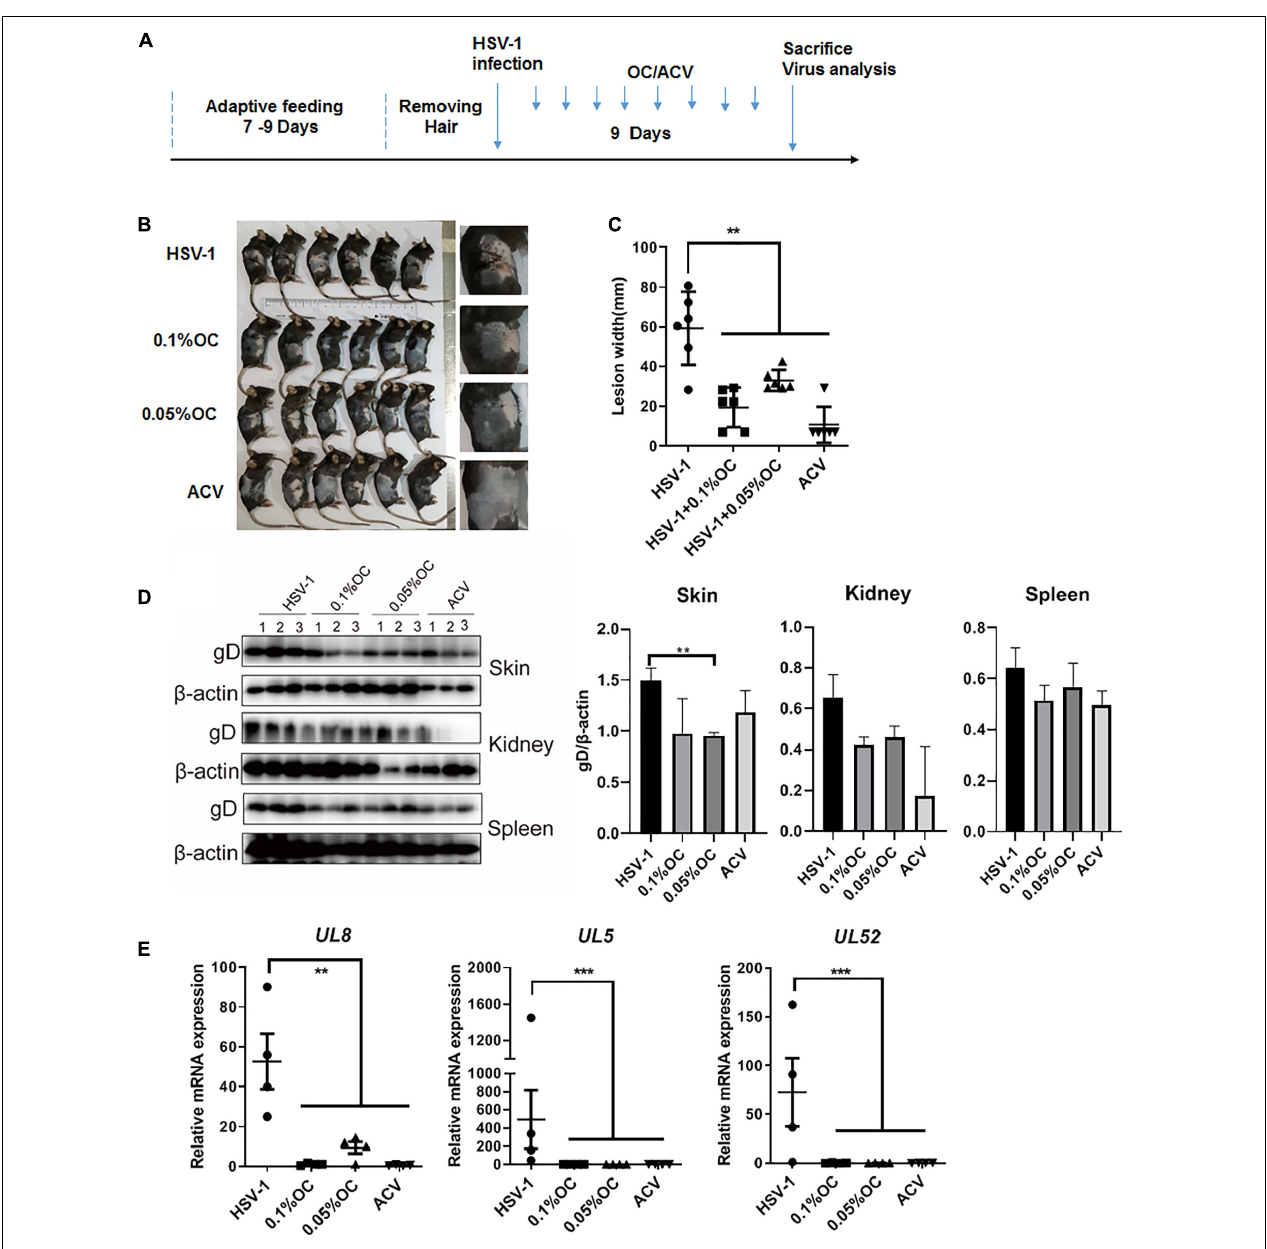
FIGURE 6 | Oleanolic acid reduces HSV-1 infection-induced skin lesions in mice. (A) Simple diagram of the in vivo experiment. (B) Gel preparations containing high or low concentration of Oleanolic acid (OC) were applied to mice with zosteriform model of HSV-1 infection once a day. After 9 consecutive days, the mice were then sacrificed for photographing. (C) The widths of the zosteriform lesions were counted by ImageJ software. (D) Total proteins in skin, kidney, and spleen were extracted, and the protein levels of viral protein gD were detected by western blot assay. Protein band intensity was quantitative analyzed by Image J software. (E) Viral RNA in HSV-1-infected skin tissues was extracted, and the mRNA expression levels of UL5 , UL8, and UL52 were detected by RT-qPCR. Data are mean ± SD ( n = 9). ** p < 0.01, *** p <